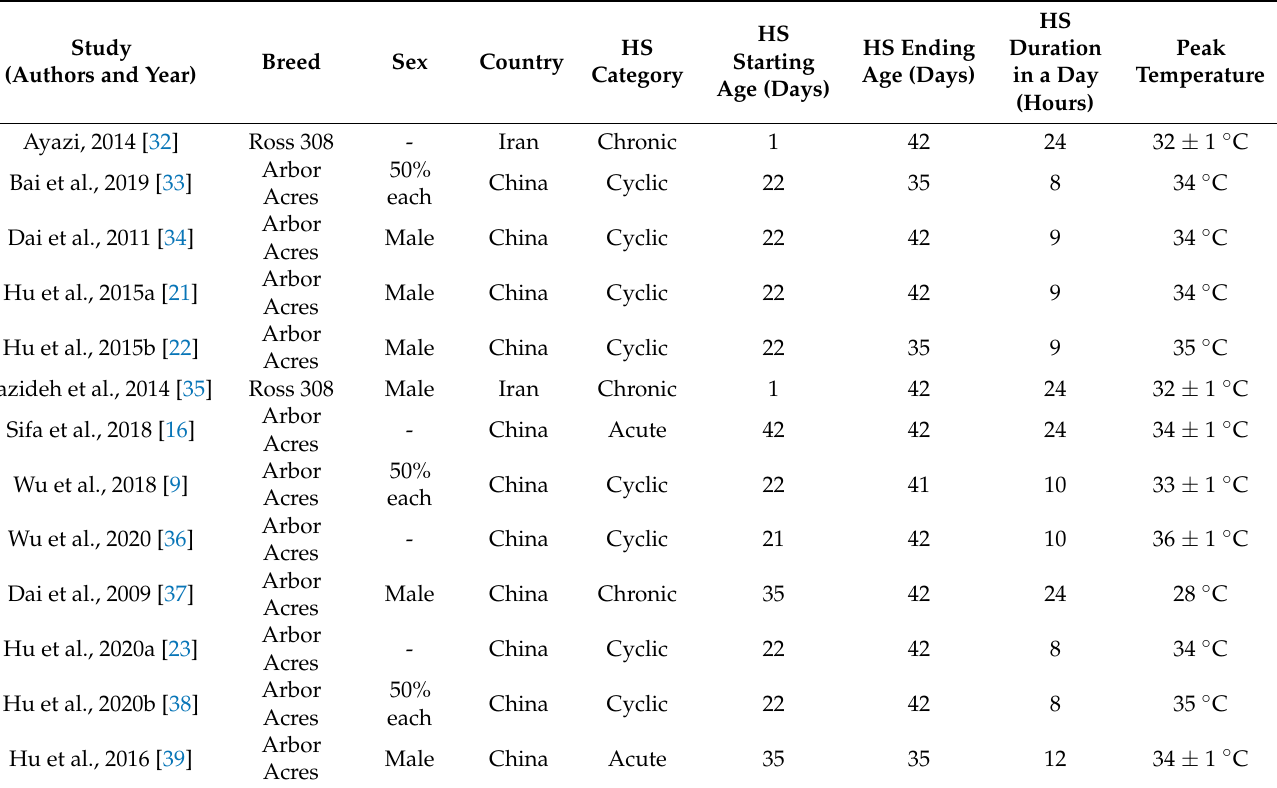
Table 1. Characteristics of studies included in the